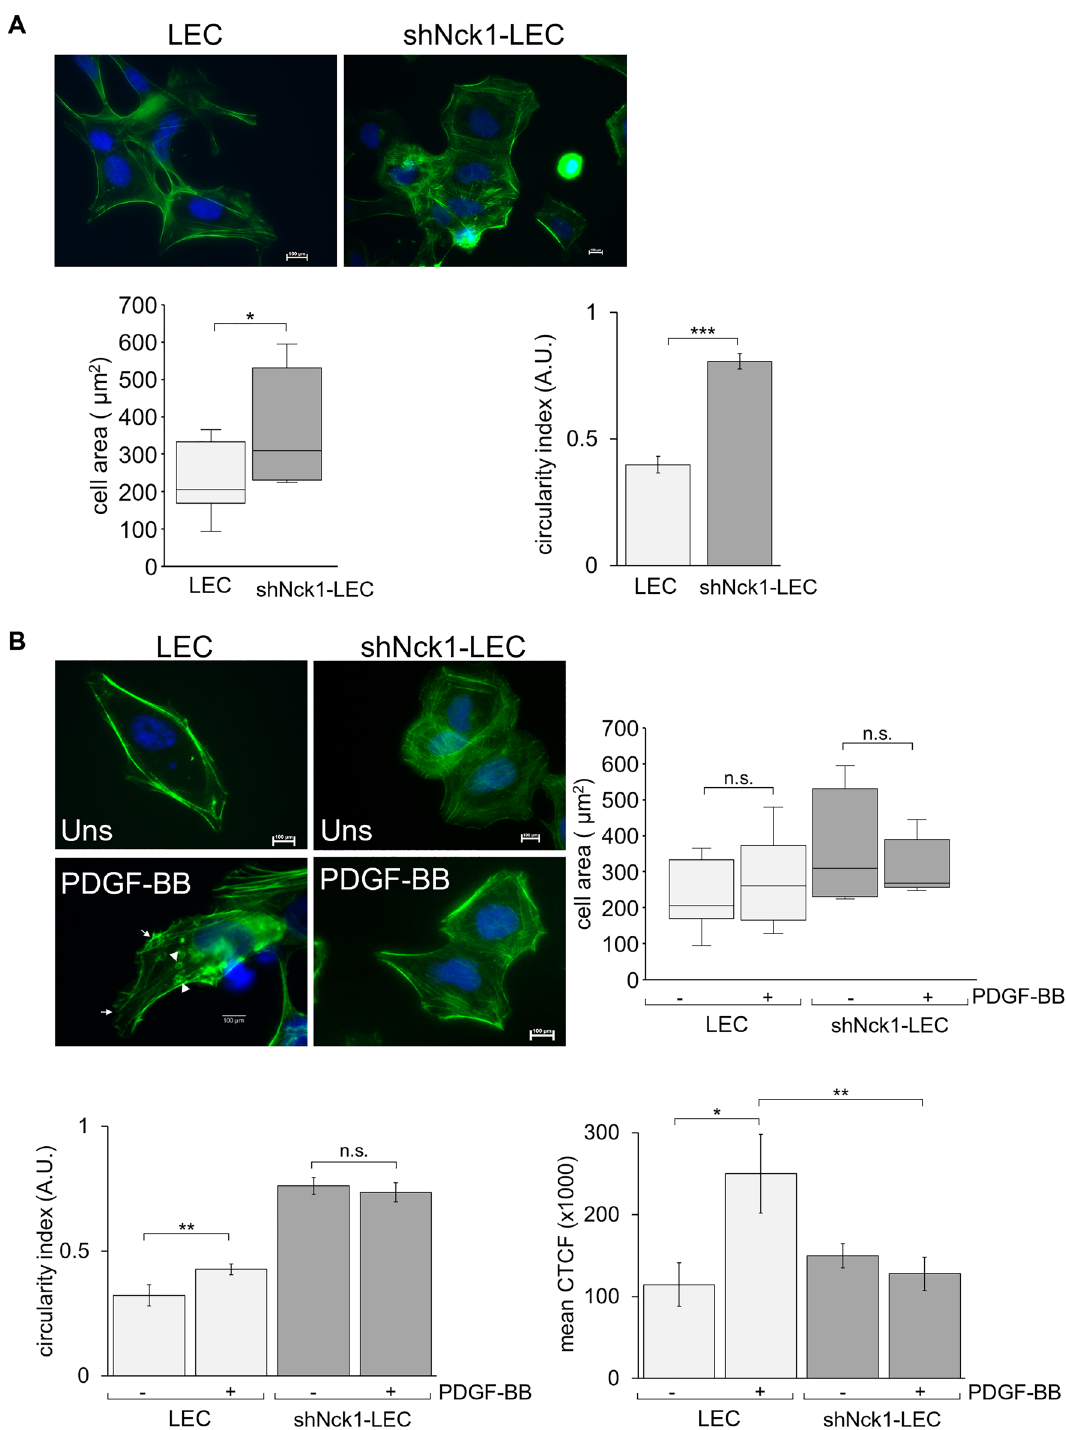
Figure 5. Nck1 adaptor protein is required for a sustained cell shape and actin reorganization. Cells were stained for actin filaments with AlexFluor 488 ‐ phalloidin staining (green). Green fluorescence signals were observed with 600× magnification. ( A ) Nck1 knockdown changed cell morphology. Quantification of areas and perimeters of at least 10 cells from three separate experiments were measured. Graph illustrates cell area and cell circularity. ( B ) Upon PDGF-BB stimulation, peripheral and dorsal ruffling were induced as detected by staining for F-actin. Cell area, cell circularity and corrected total fluorescence (CTCF) intensity were quantified. Data are representative of three independent experiments and represent the mean ± SEM. Arrows and arrow heads indicate peripheral and dorsal ruffling, respectively. n.s. = not significant, *p < 0.05, **p <